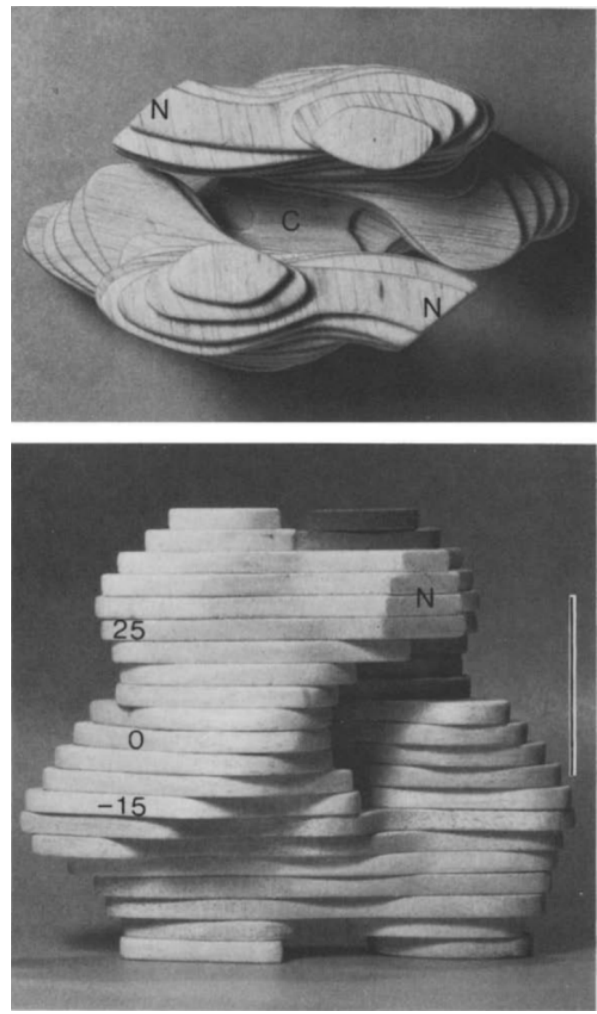
Figure 4. Reconstruction of a three-dimensional model of a Na,K- ATPase dimer from a tilt series of electron-microscopical images taken from a two-dimensional crystal of Na,K-ATPase in mem- brane fragments. Upper panel: top view, lower panel side view. The vertical bar indicates the assumed position of the lipid membrane, the cytoplasmic protrusion of the protein is on the bottom. (Figure taken from Ref. 109, with permission)